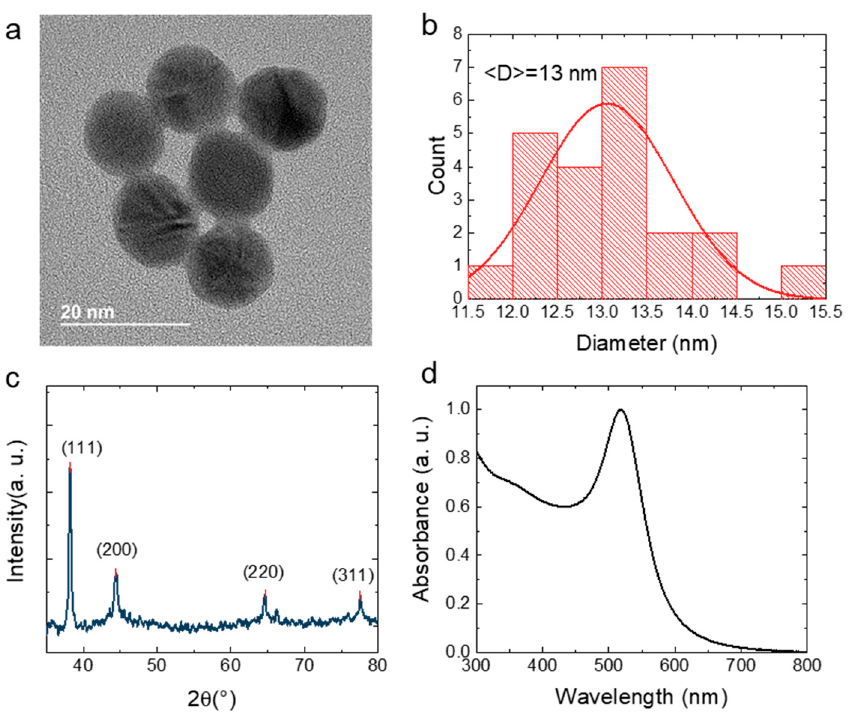
Figure 1. ( a ) TEM image of the AuNPs. ( b ) Size distribution of the AuNPs. ( c ) XRD spectrum of the AuNPs. ( d ) Ultraviolet–visible (UV-Vis) absorption spectrum of the AuNPs solution.